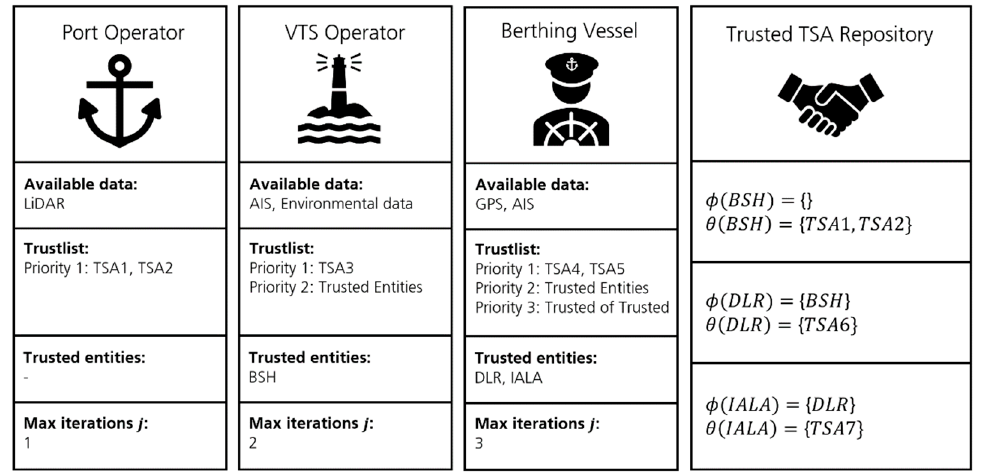
Figure 7 . Initial situation of the evaluation scenario . Figure 7. Initial situation of the evaluation